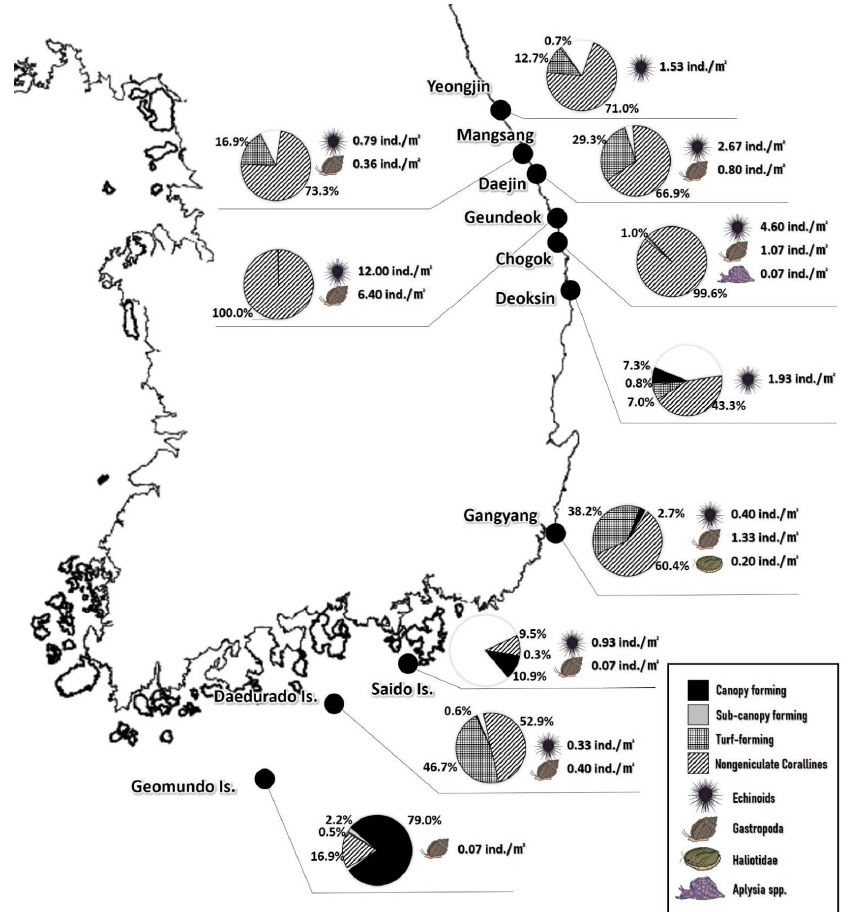
Figure 1. Coverage of seaweed group and grazer density at the study